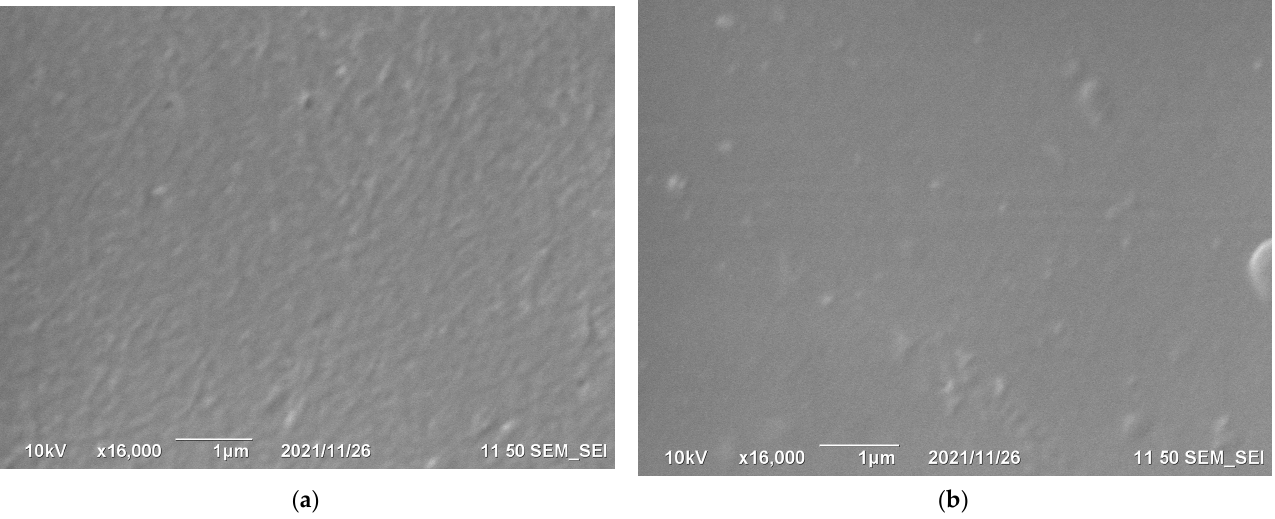
Figure 4. SEM images of the of the PTMSP surface ( a ) and the MF-4SC surface ( b ) of the bilayer composite membrane.